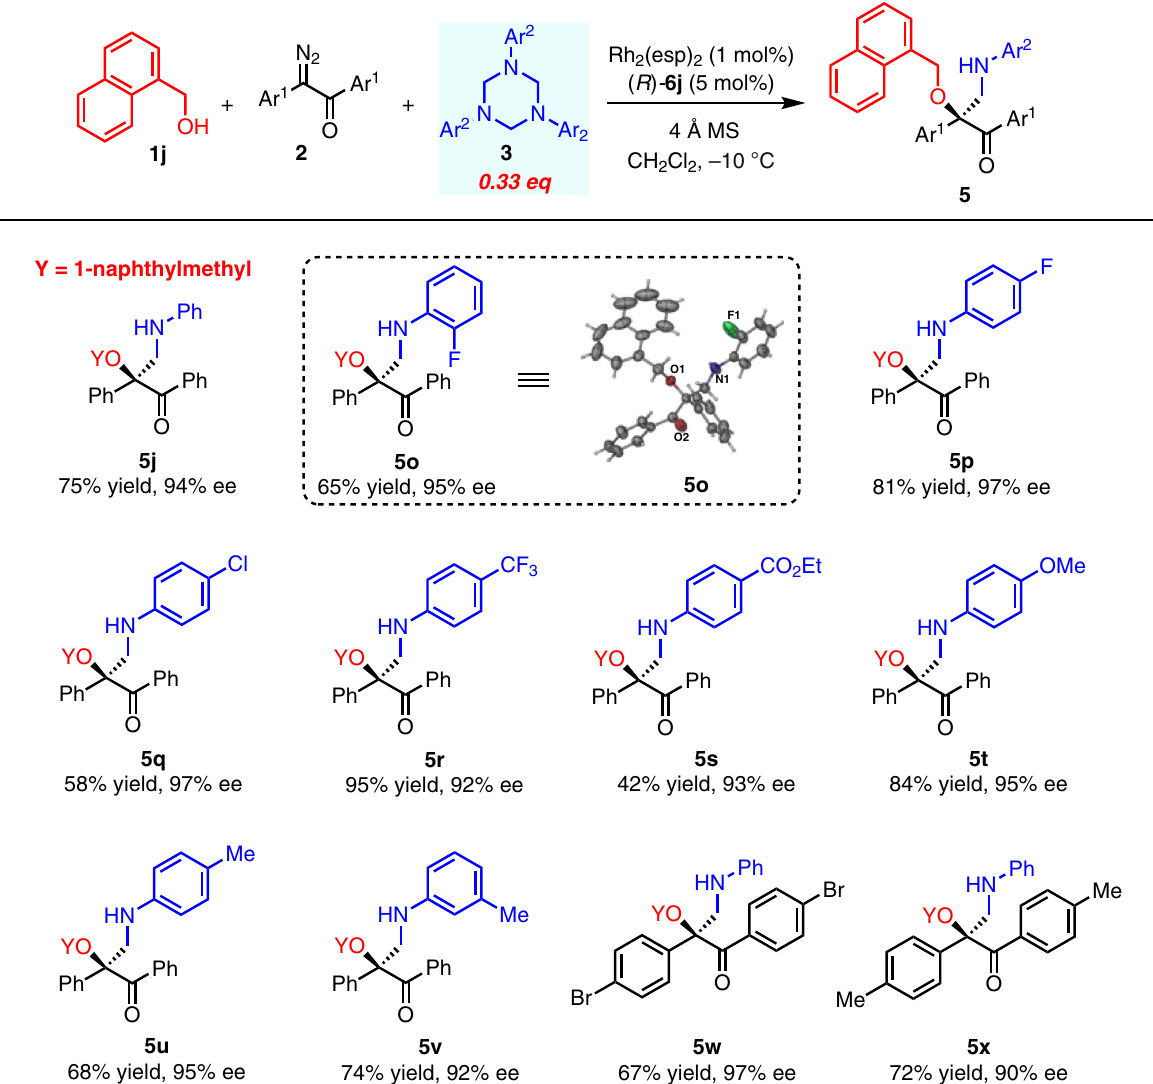
Fig. 3 Substrates Scope of 1,3,5-Triaryl-1,3,5-triazines and diazo ketones. All reactions were run in 0.3 mmol scale of 1j , 1j : 2 : 3 = 1/1/0.33. All yields shown were based on isolated products. Ee values were determined by chiral HPLC